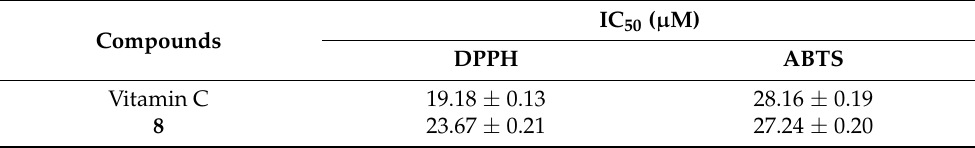
Table 4. OSe compound 8 ′ s redox properties. Compounds